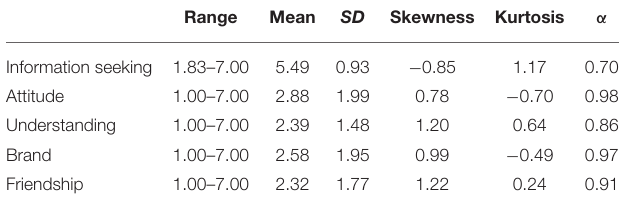
TABLE 2 | Descriptive statistics.